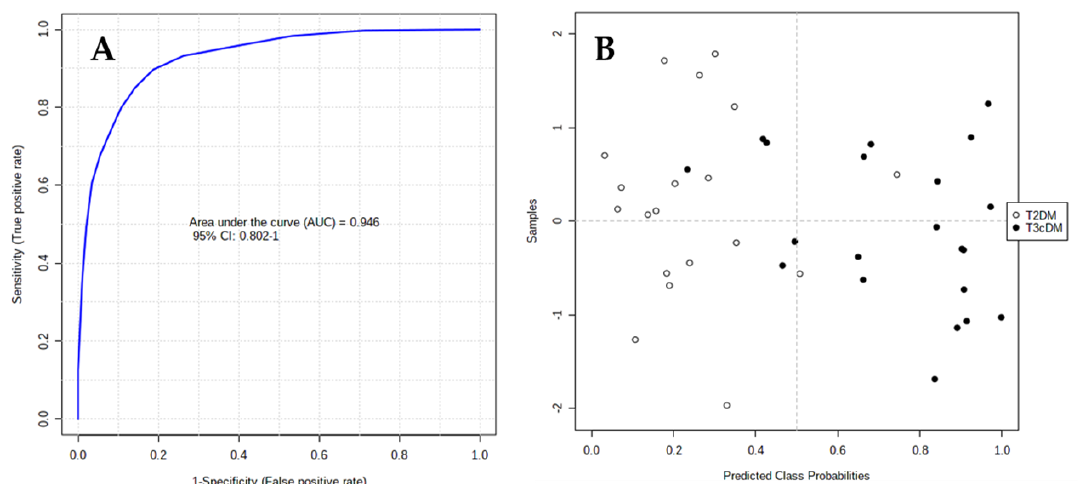
Figure 4. ROC curve plot for the final model obtained by multivariate combination of individual biomarkers: ( A ) ROC curve plot was created from the averaged results of 100 cross-validations. As an outcome from averaged cross-validations, it possible to predict the classification of each patient sample; ( B ) as a consequence of the balanced subsampling approach incorporated in the algorithm, the classification limit is x = 0.5 (dotted line).